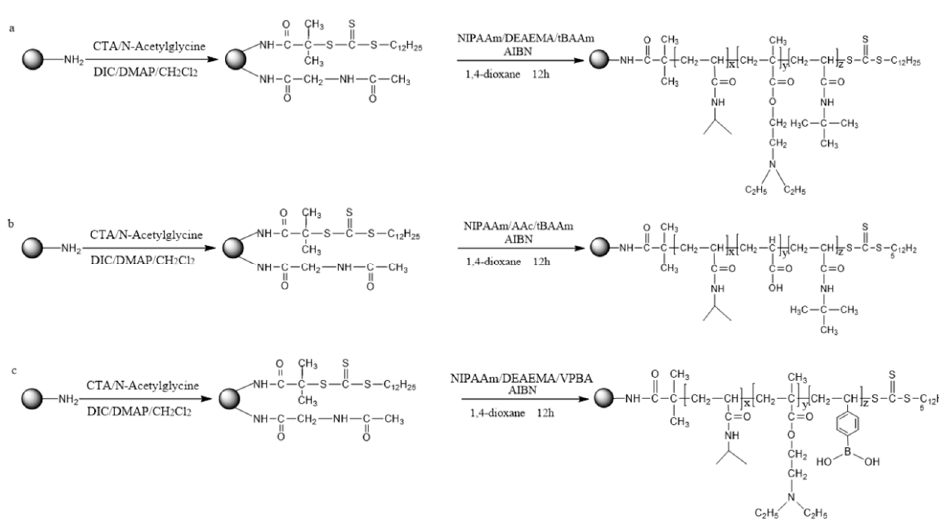
Figure 10. Synthesis of temperature-responsive polymer modified silica. ( a ) Synthesis of poly(NIPAAm- co -DEAEMA- co - t BAAm)-grafted silica; ( b ) synthesis of poly(NIPAAm- co -AAc- co -tBAAm)-grafted silica; and ( c ) synthesis of poly(NIPAAm- co -DMAEMA- co -VPBA)-grafted silica.